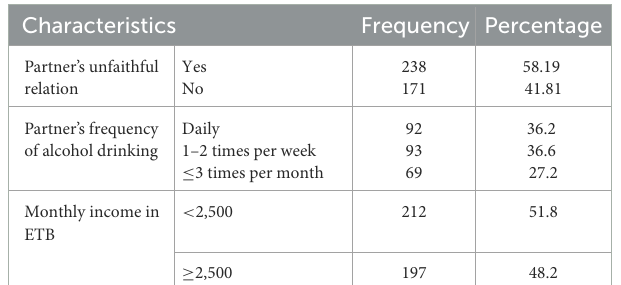
TABLE 2 Obstetrics characteristics of participants ( n =